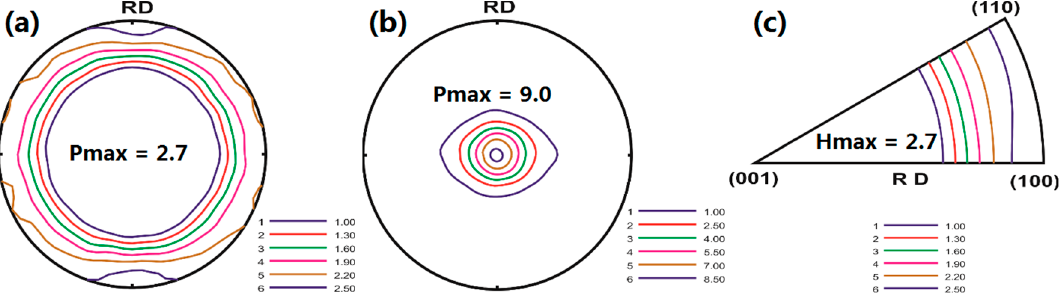
Figure 3. The initial pole figure of Z1: ( a ) (10.0) pole figure; ( b ) (00.2) pole figure; ( c ) the inverse pole figure in RD.